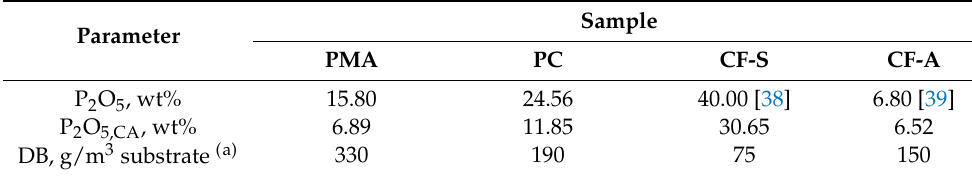
Table 10. Content of total phosphorus (P 2 O 5 ) and bioavailable phosphorus (P 2 O 5 , CA ) in the tested samples, and the defined basic doses (DB) of the fertiliser.